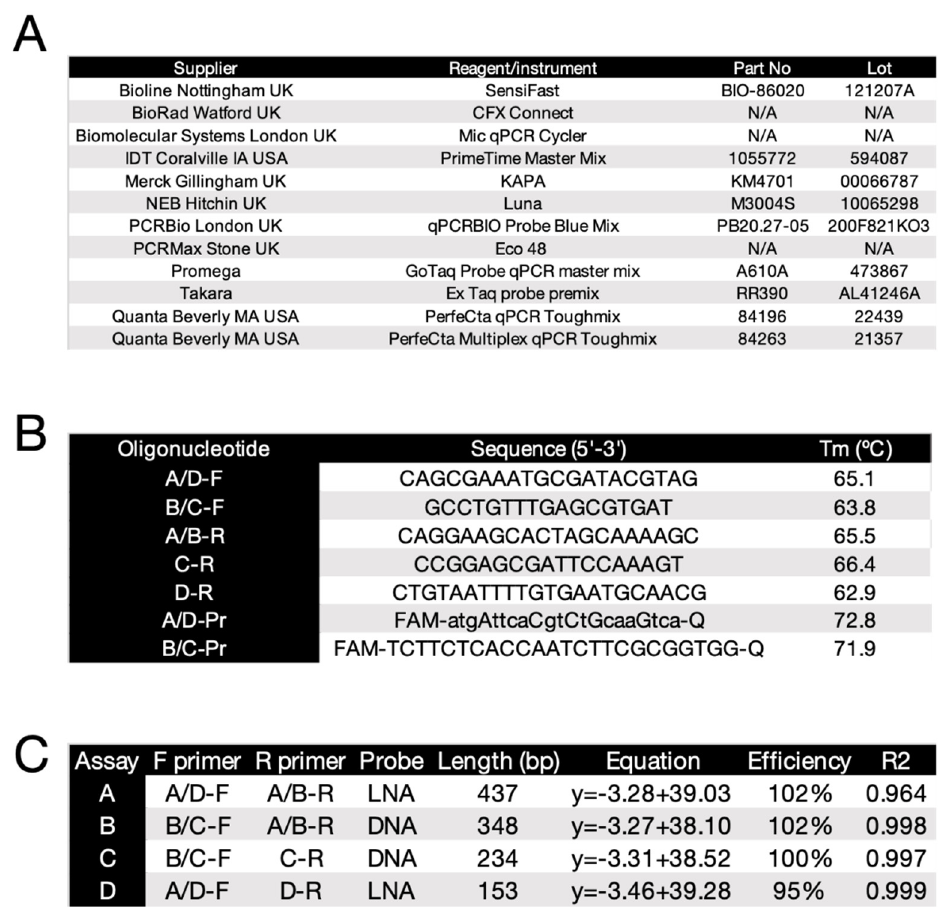
Figure 1. Reagents, instruments, oligonucleotides and assays for dilution experiments. ( A ) Suppliers and materials/instruments used in this report; ( B ) Oligonucleotide sequences. The capital letters in oligonucleotide A/D-Pr designate LNA bases; ( C ) Details of the four assays. PCR efficiencies were established using IDT’s PrimeTime master mix.